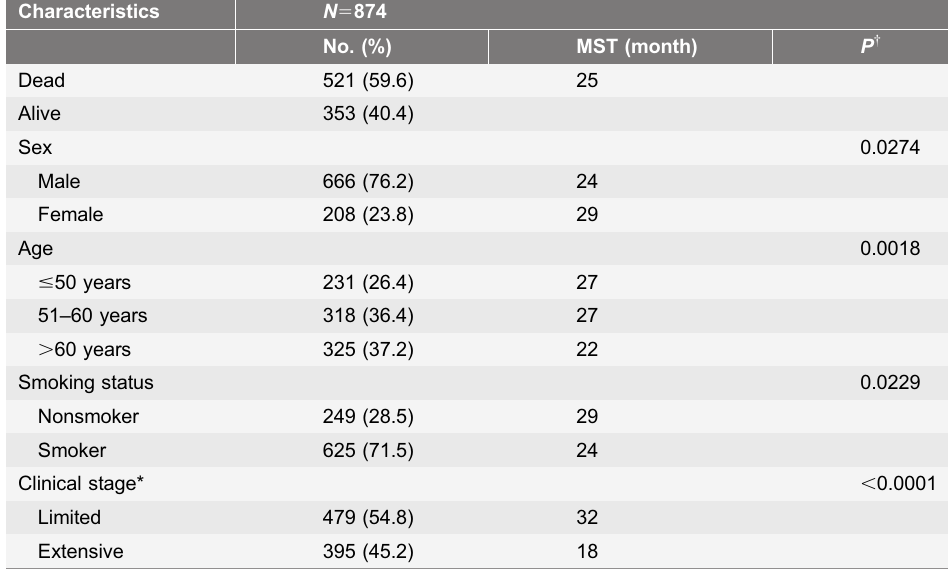
Table 1. Clinical characteristics of 874 patients with small-cell lung cancer.